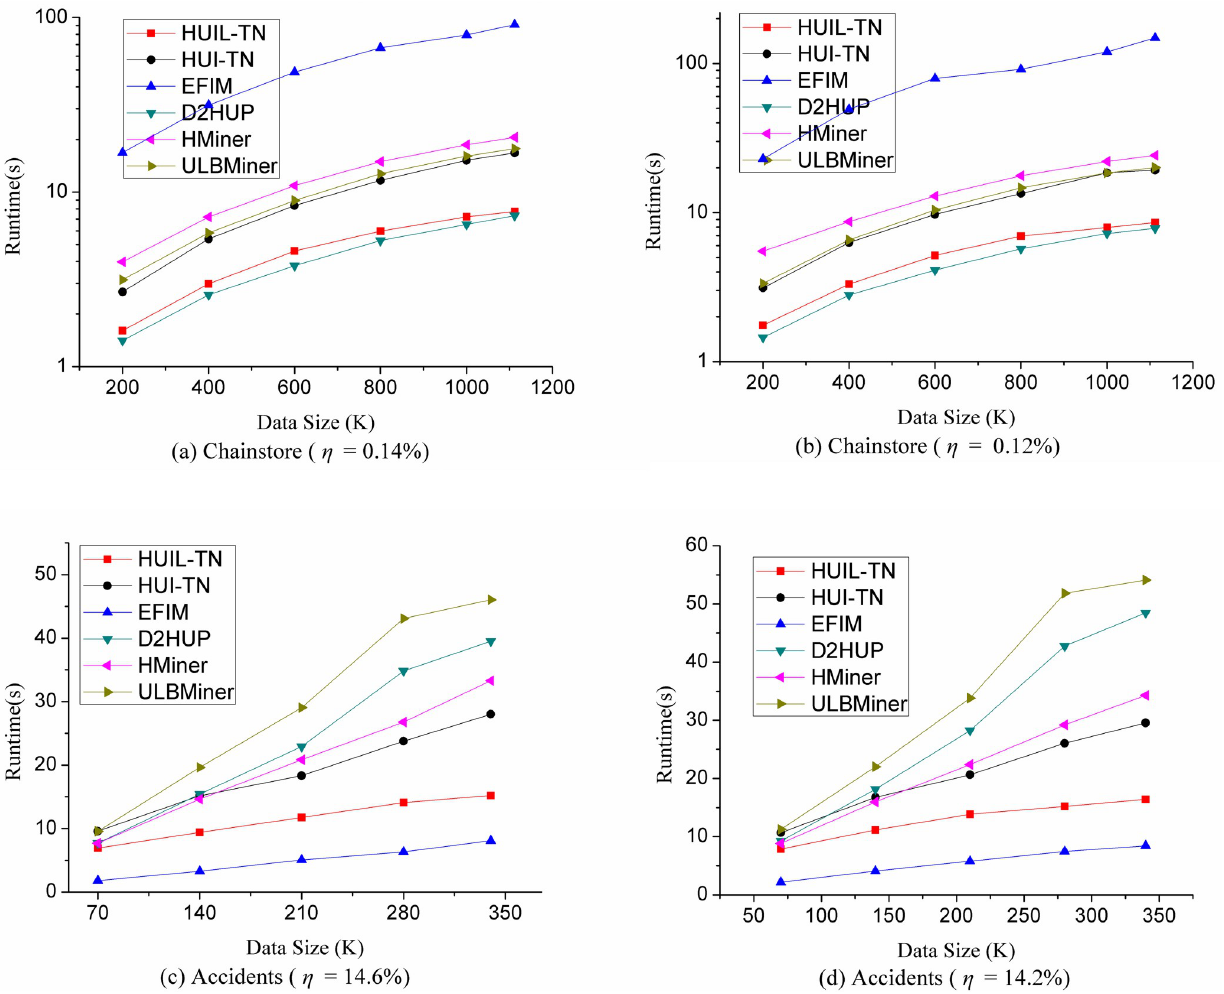
Fig 9. Comparison of runtime under varied dataset